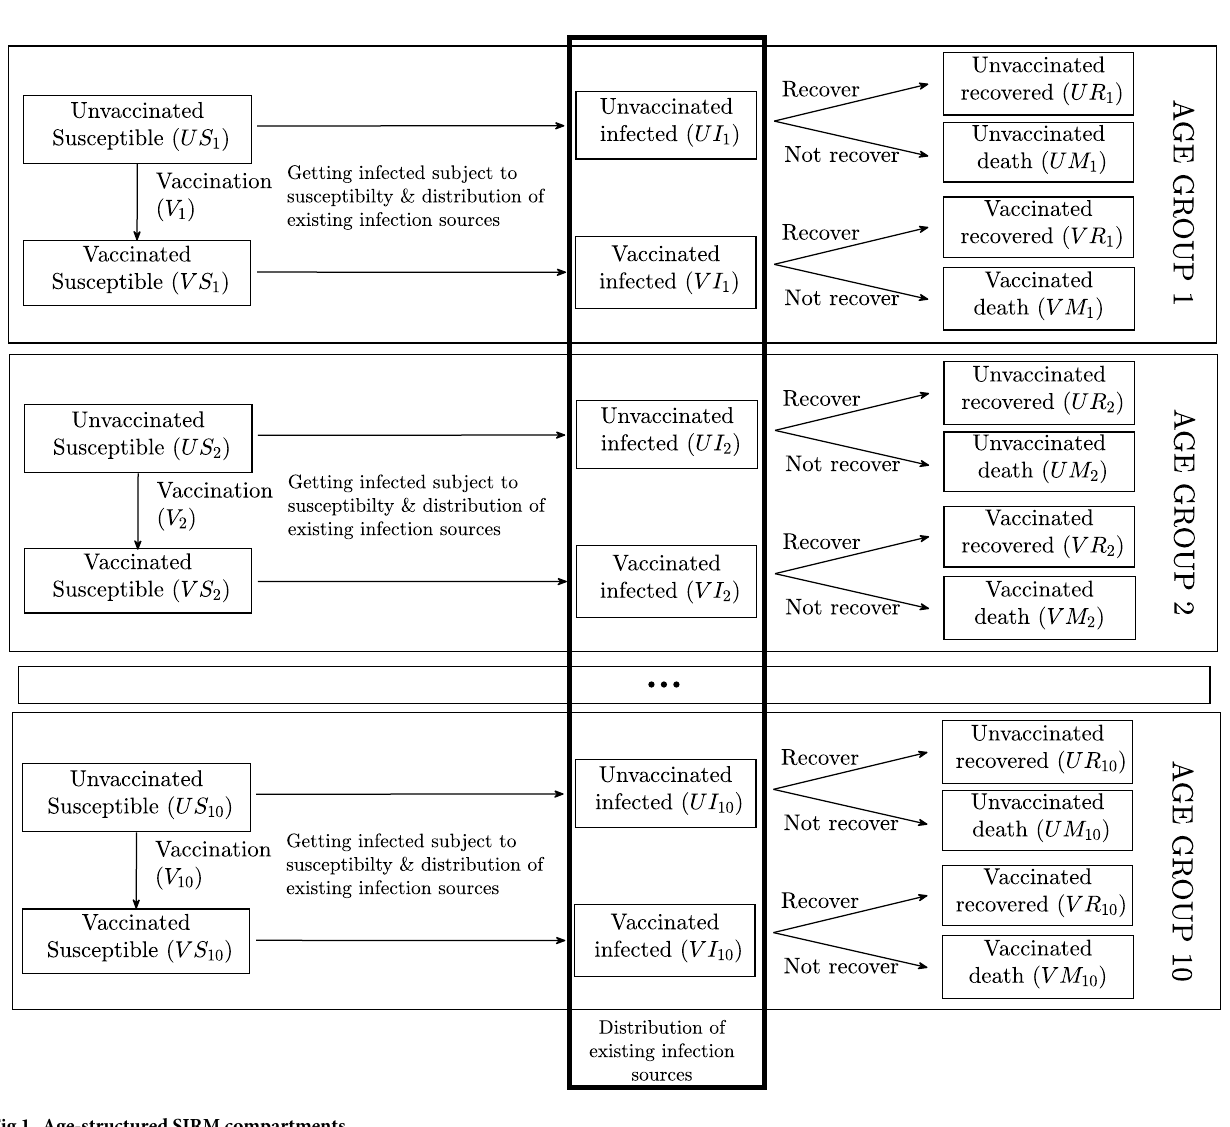
Fig 1. Age-structured SIRM